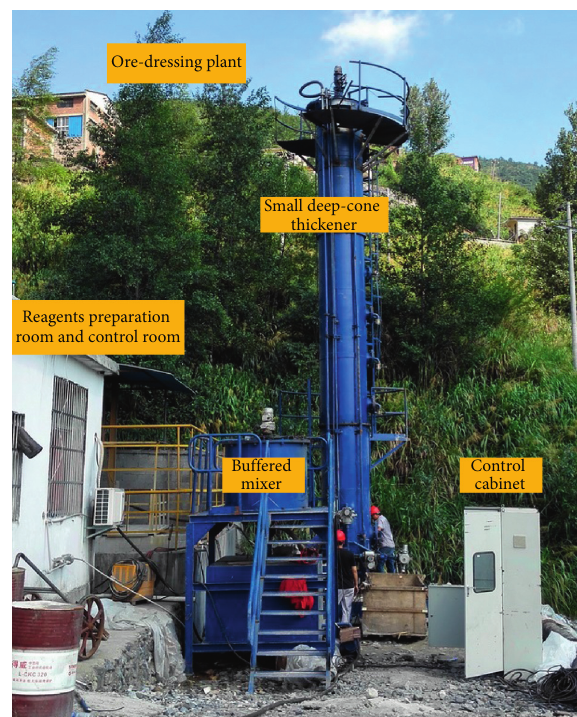
Figure 3: Layout of the semi-industrial